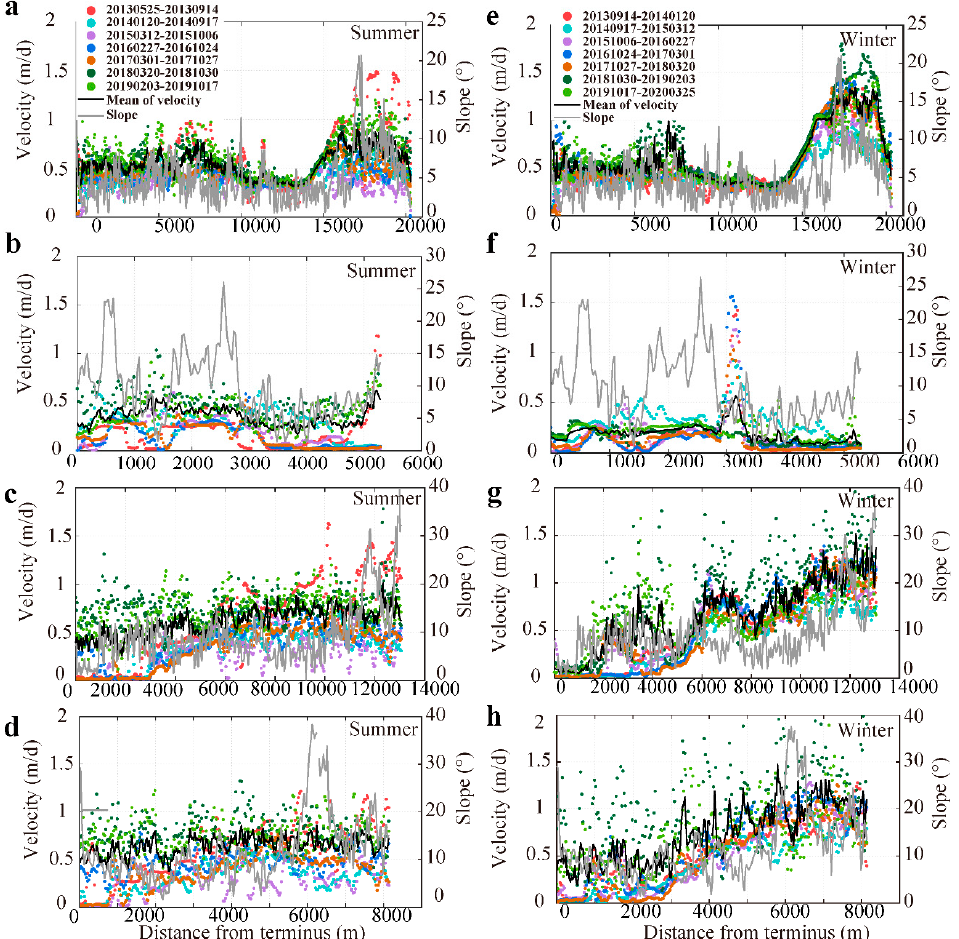
Figure 8. Summer (left, 2013–2019) and winter (right, 2013–2020) center flowline velocities vs. distance from terminus: Yanong Glacier ( a , e ) (GLIMS ID G096657E29334N); Parlung No.4 Glacier ( b , f ) (GLIMS ID G096920E29228N); Azha ( c , g ) (GLIMS ID G096818E29132N) and Xueyougu Glacier ( d , h ) (GLIMS ID G096758E29147N); mean of velocity (black solid line).